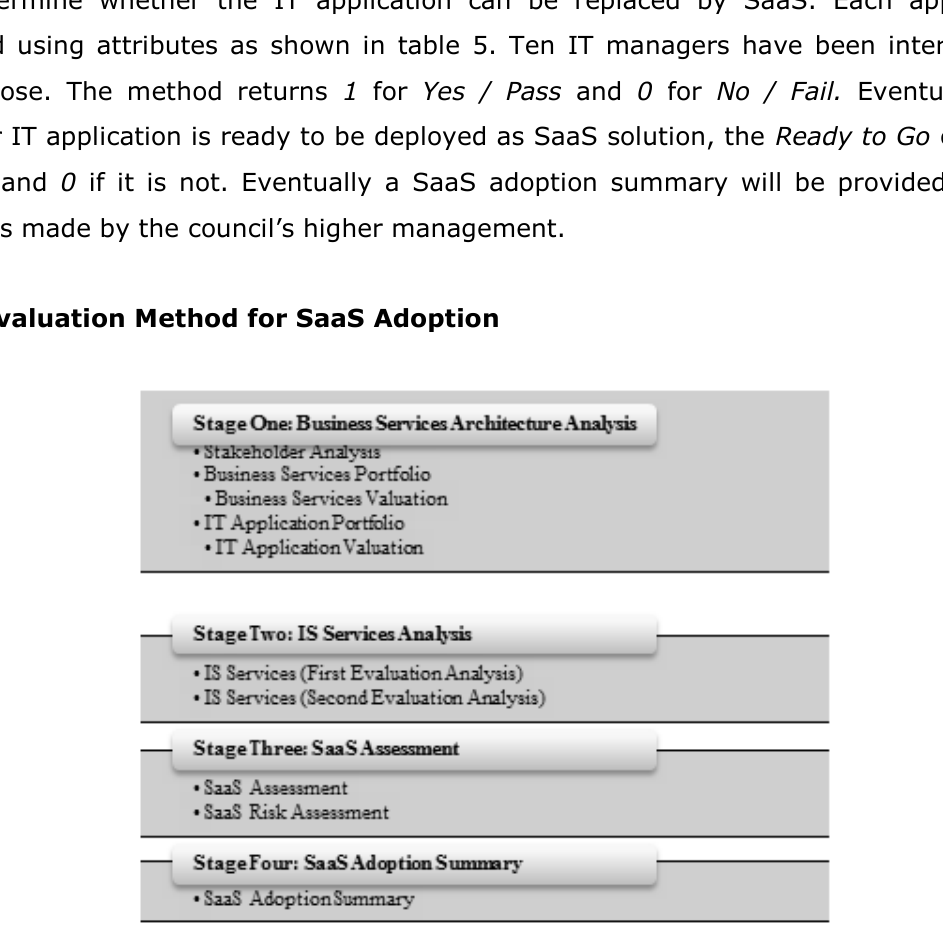
Figure 4. The evaluation method